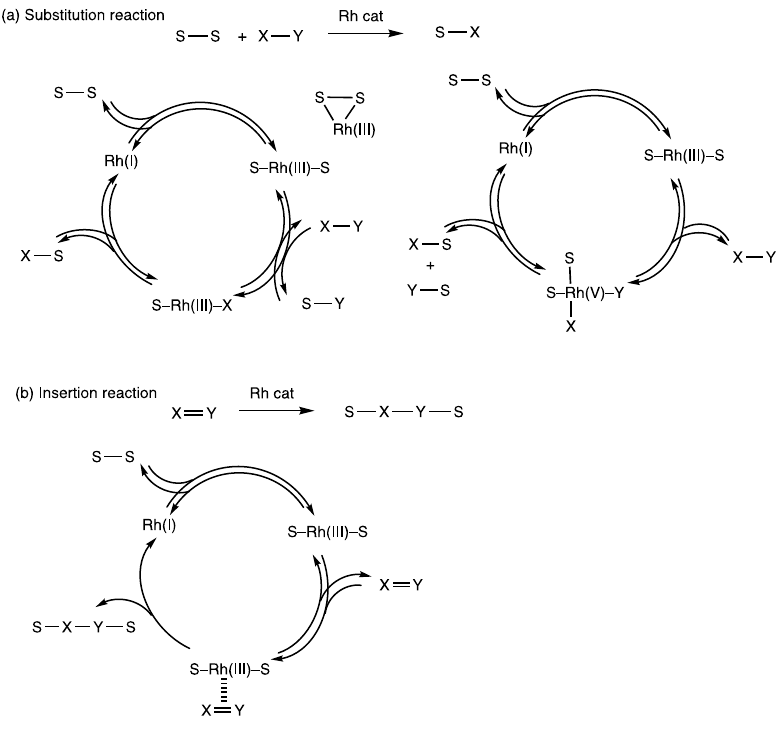
Figure 7. Mechanistic models of rhodium-catalyzed ( a ) substitution reactions and ( b ) insertion reactions with disulfides.